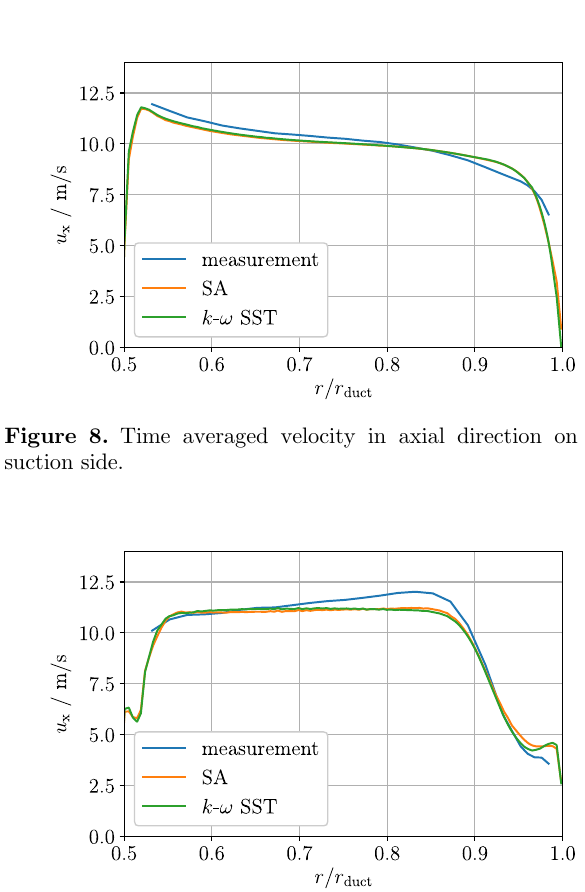
Figure 6. DES blending between LES and URANS simulation.